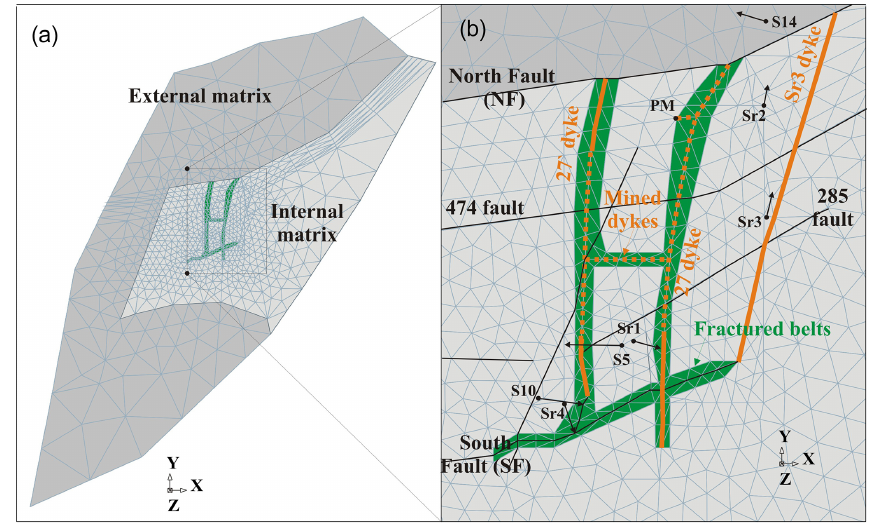
Figure 6. Model geometry. The model comprises two areas. The external matrix area is treated as an equivalent porous media without explicit fractures, because not all of the main structures have been identified. At the local level (right picture), the main structures are explicitly taken into account, including the fractures, dykes 27, 27’, and SR3, and the mine itself, which is excavated in both dykes. The structures are represented by means of 2-D elements. The Maderos creek is embedded in the SF. Projections of the boreholes that are closer to the mine are represented by black dots on the surface and by an arrow pointing to the borehole